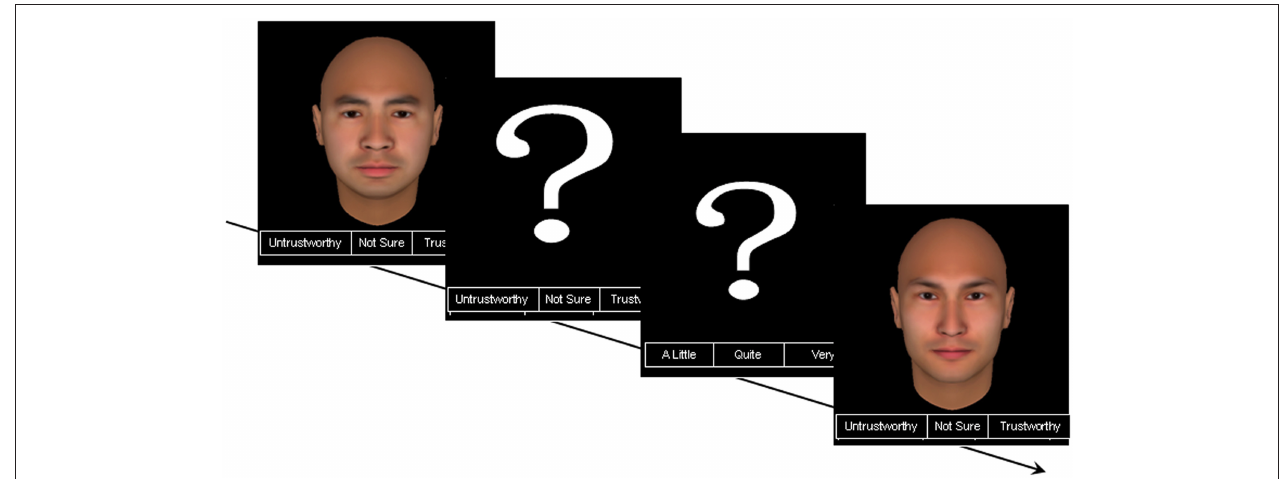
FIGURE 1 | An example of two trustworthiness judgment